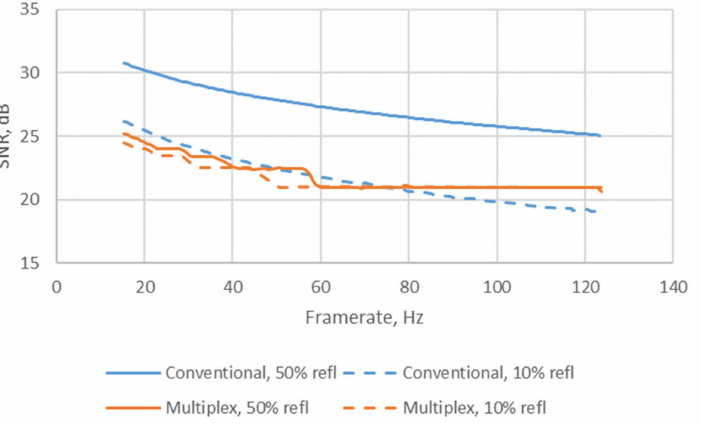
Figure 8. Shows the SNR behavior of the conventional spectrograph sensing vs. the CA multiplexed sensing for the integrated visible-SWIR sensor